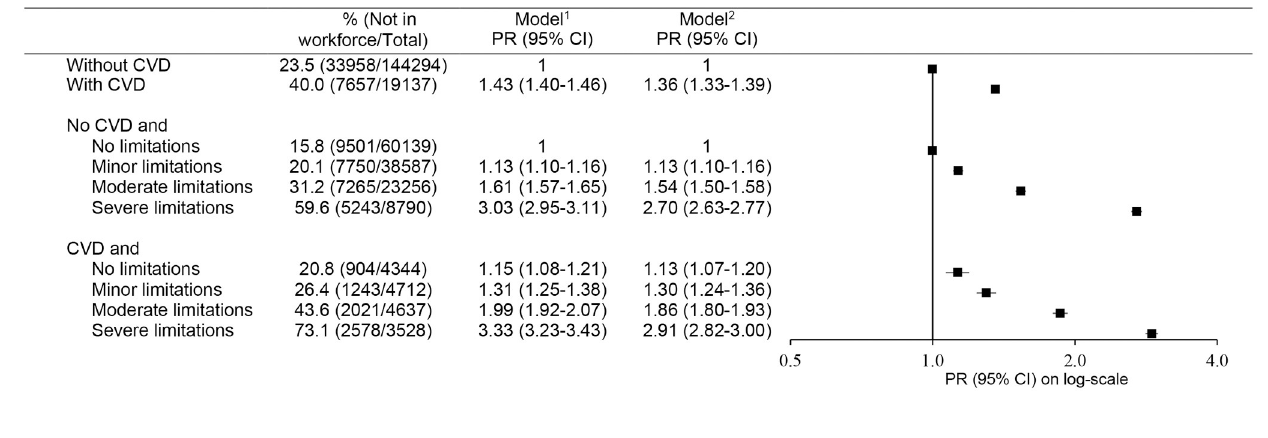
Fig 4. Non-participation in the workforce: Prevalence and adjusted prevalence ratios according to joint categories of physical functioning limitations and CVD.